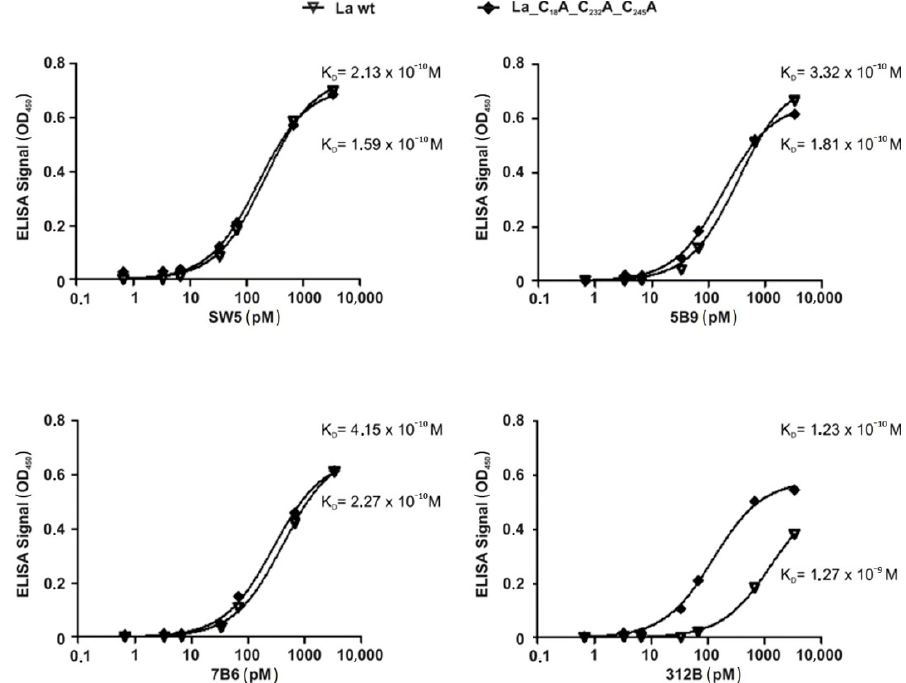
Figure 10. Comparison of apparent K D values of anti-La mAbs to the reduced and oxidized form of La protein. Wildtype La protein (wt) and the triple cysteine mutant (La_C 18 A_C 232 A_C 245 A) were treated with CuSO 4, and the K D values were determined by ELISA for the anti-La mAbs SW5, 5B9, 7B6, and 312B.